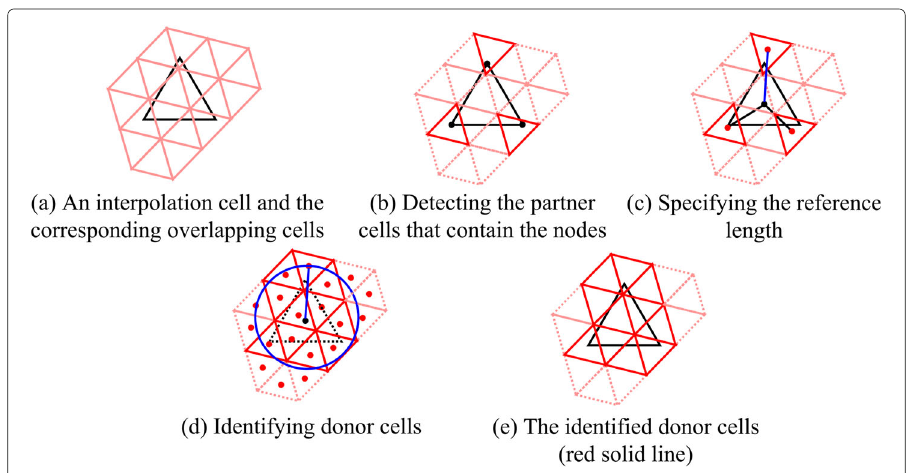
Fig. 4 Donor cell identification procedure (illustrated in